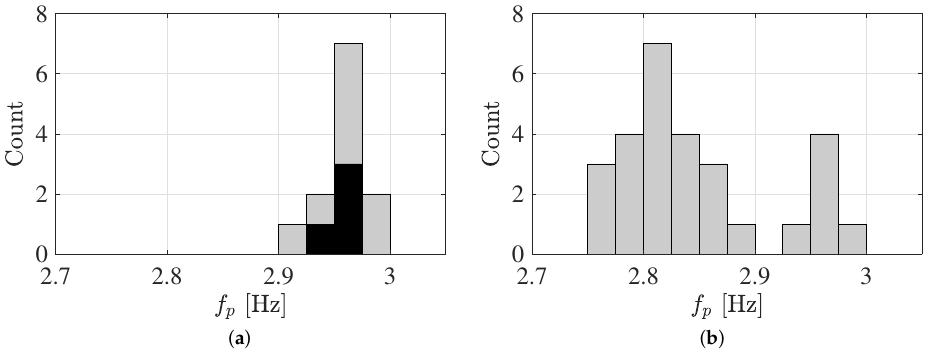
Figure 14. Histogram of the average pacing rate per participant for all subtests: ( a ) test 1 (black) and test 2 (gray) and ( b ) test